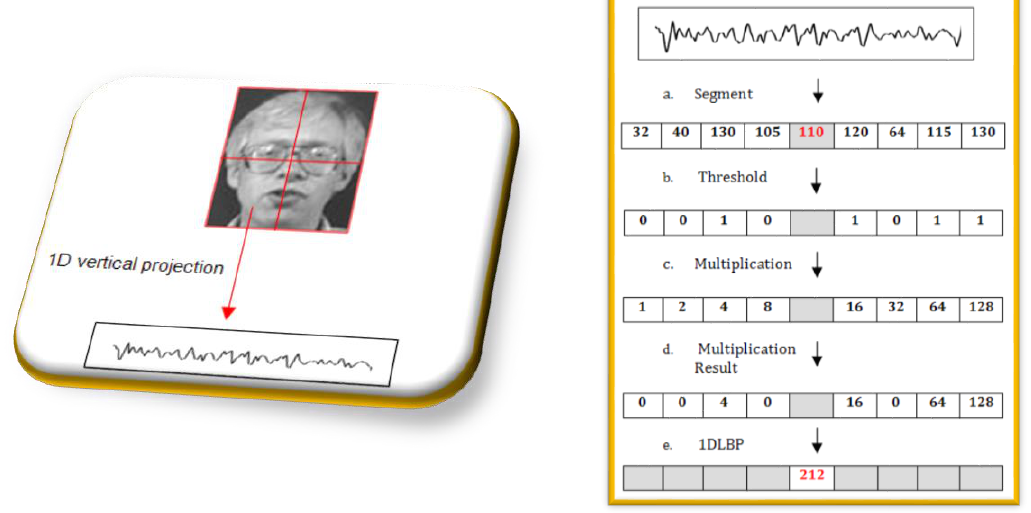
Figure 22. Example of one-dimensional local binary pattern (1DLBP) facial calculation.